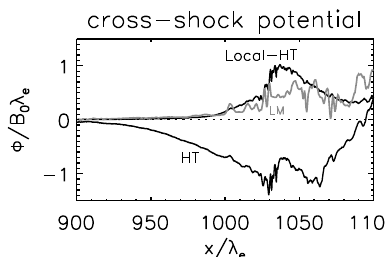
Figure 3. Example of the electron distribution function at the time shown in Fig. 1 in the de Hoffmann–Teller frame, the spatial coor- dinate x = 1020 λ e (at the shock ramp), and the pitch angle 65 ◦ ob- tained by the PIC simulation (solid line in black) and that obtained by Liouville mapping (in gray